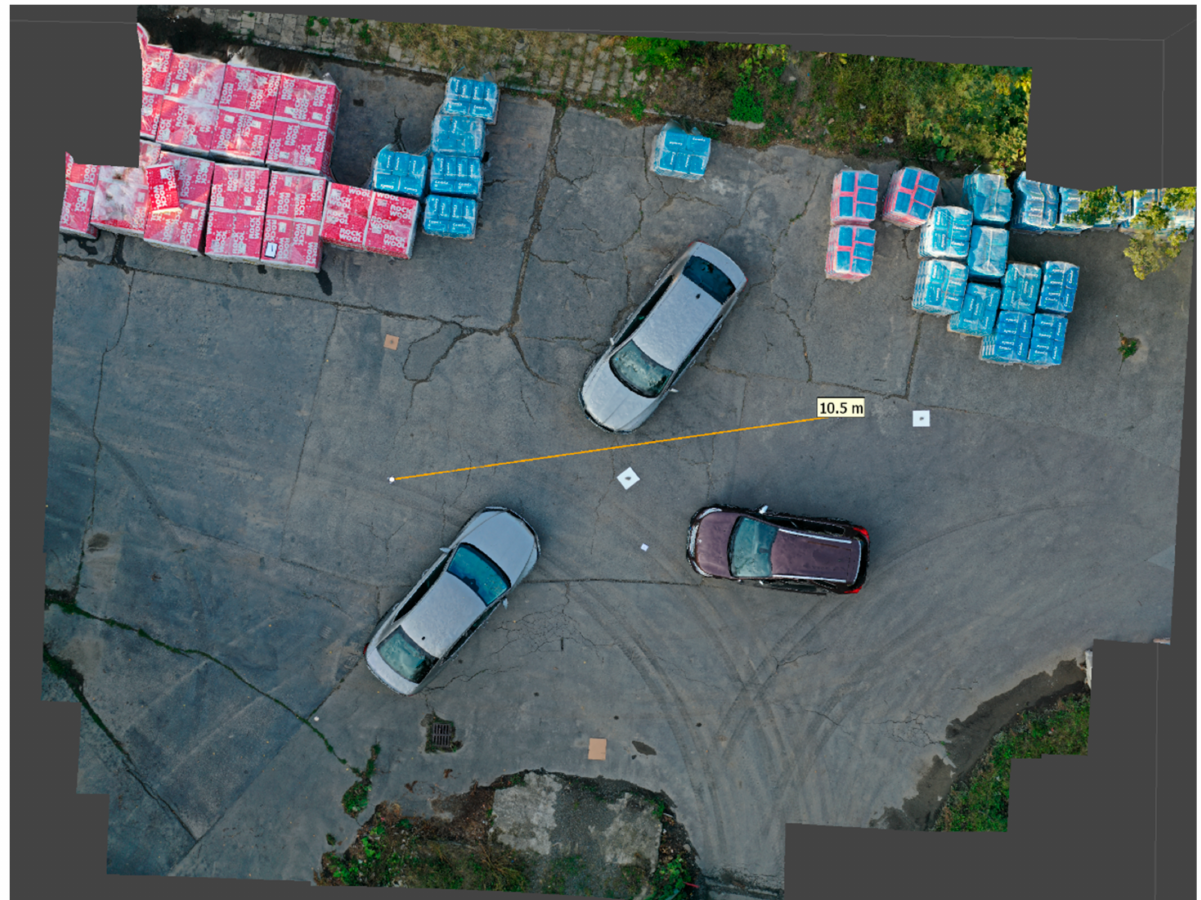
Figure 3. Perpendicular view of the final 3D model, with an example of